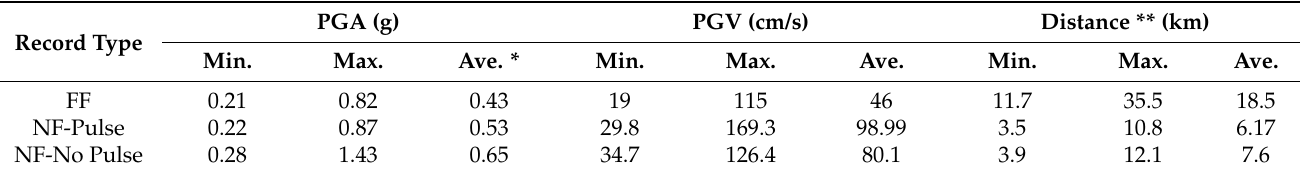
Table 3. Specification of PGA and PGV for record sets.